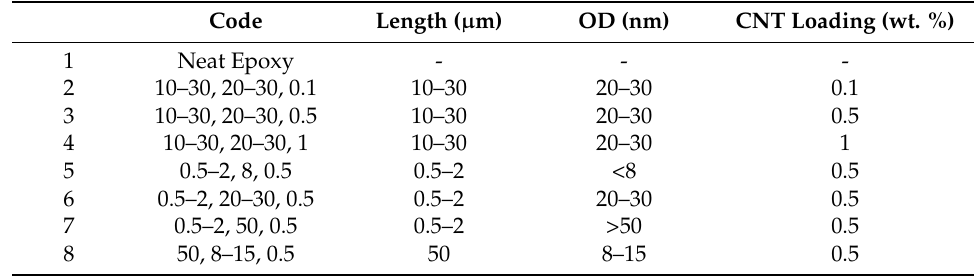
Table 3. Type and loading of carbon nanotubes (CNTs) of all samples. The code is in the format of “length, diameter,